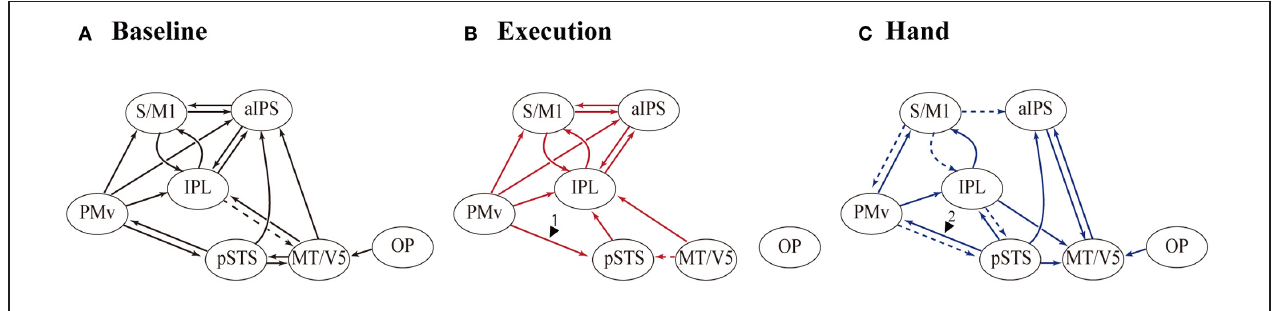
FIGURE 5 | Effective connectivity evaluated by DCM. The paths of effective connectivity shown are significantly larger (solid arrows) or smaller (dashed arrows) than 0 (one-sample t -test with FDR correction).